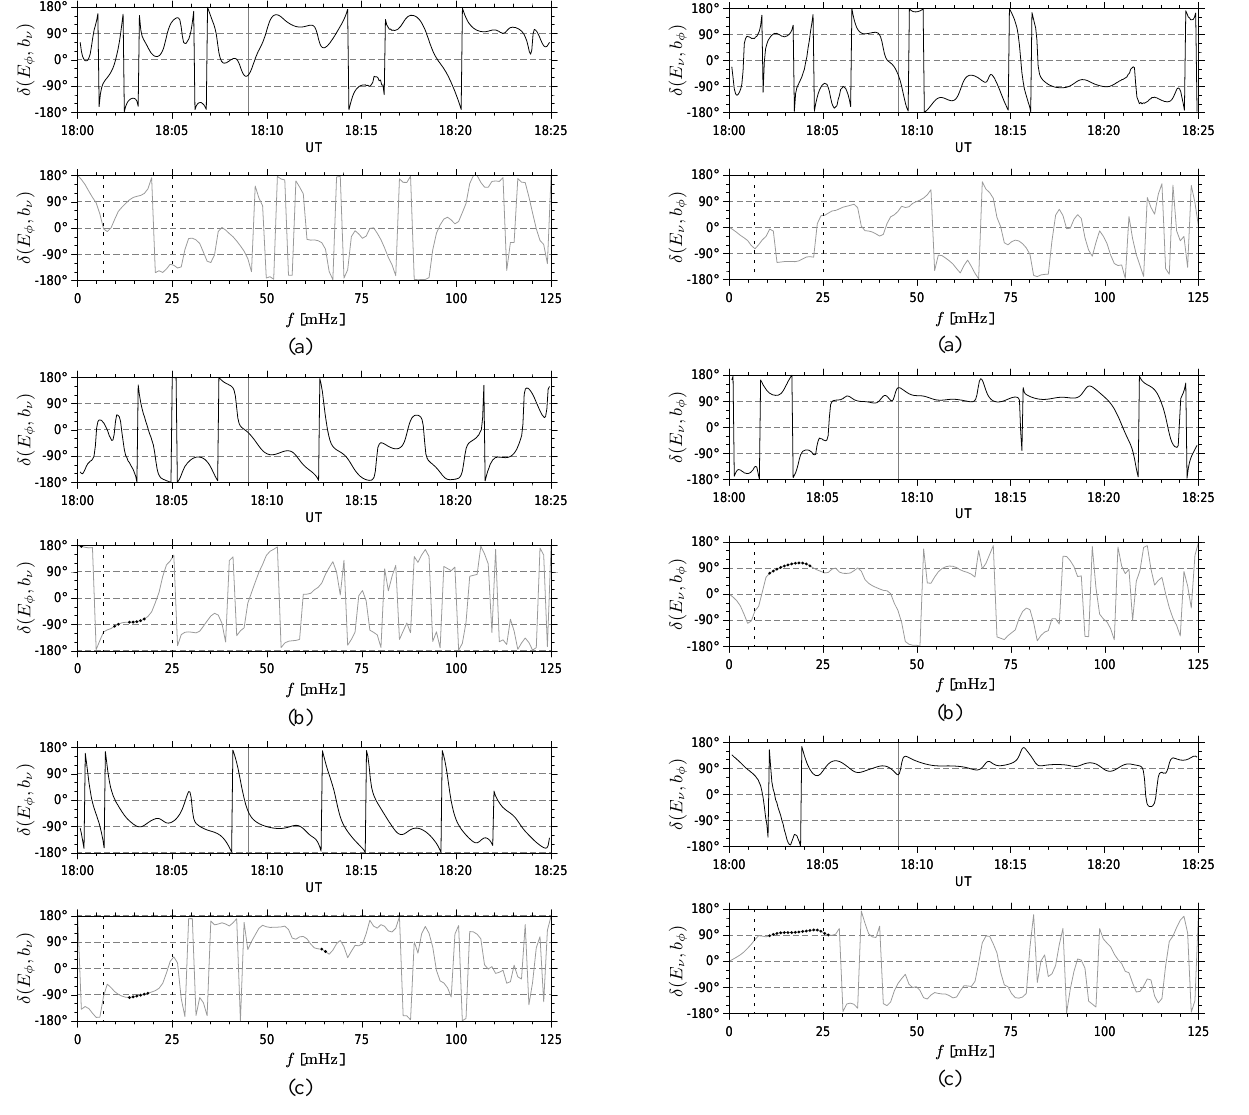
aged over the Pi2 band. At both C2 and C4 the condition δ ( E ν , b φ ) = 90 ◦ lies close to the calculated range of un- certainty. The origin of the data in Table 2c is plotted in Figure 9. It is apparent that E ν and b φ are coherent with a consistent phase difference over an appreciable portion of the Pi2 range. Furthermore, the phase difference is stable at approximately 90 ◦ for the entire duration of the event. and − 90 ◦ respectively. Altogether these are indicative of